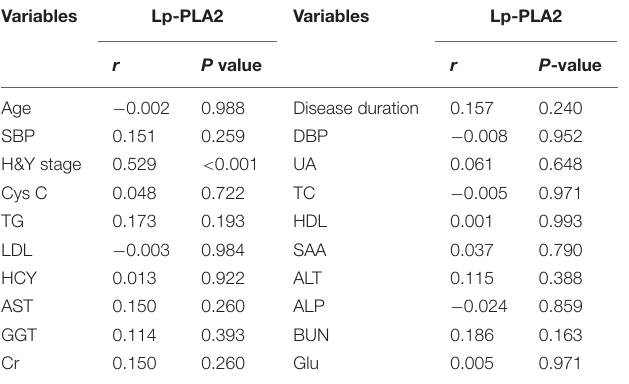
TABLE 5 | Correlation analysis between Lp-PLA2 and other indicators.